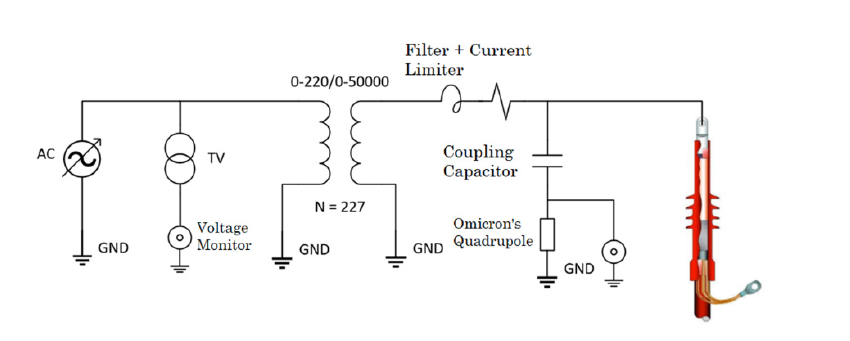
Figure 8. Equivalent circuit of the test circuit.